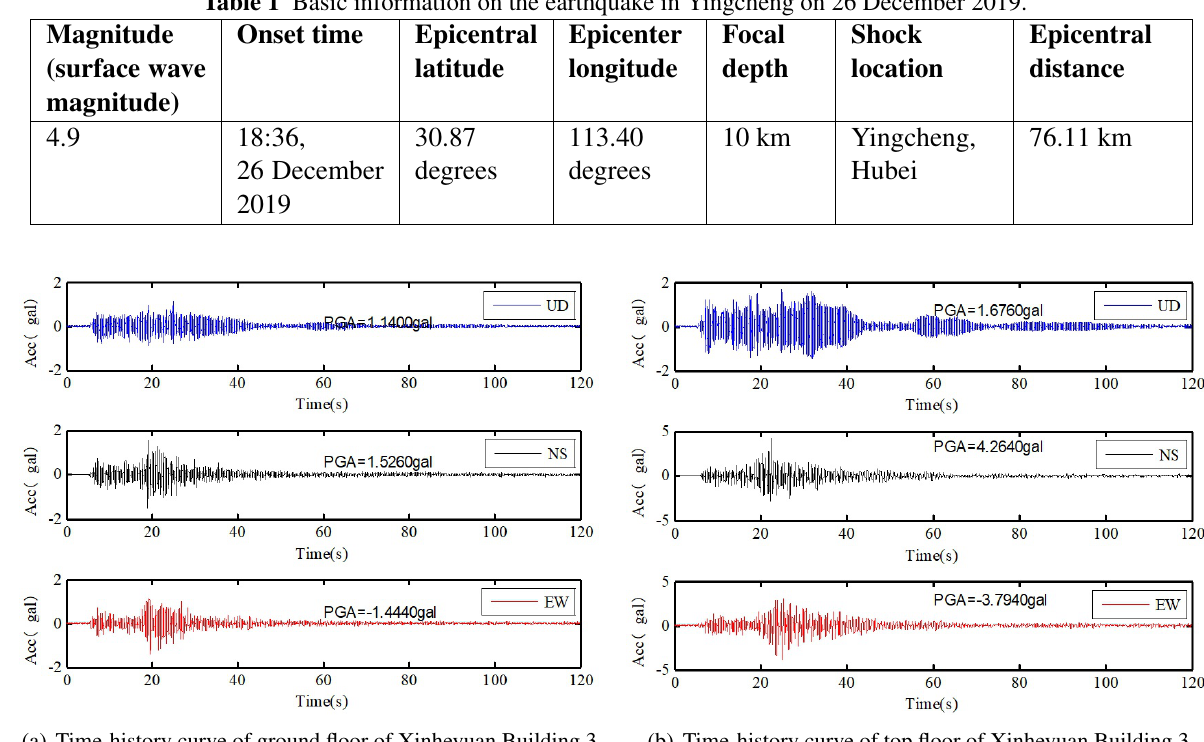
Fig. 5 Acceleration time-history curve of the Xinheyuan Court building during the 4.9-magnitude earthquake in Yingcheng,